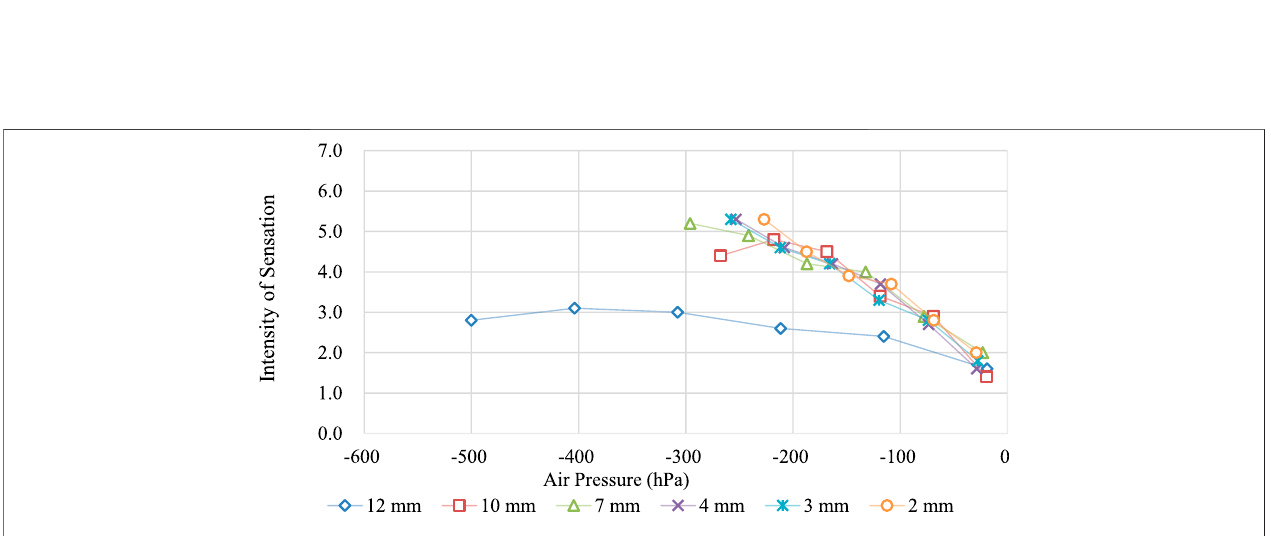
Frontiers in Virtual Reality |